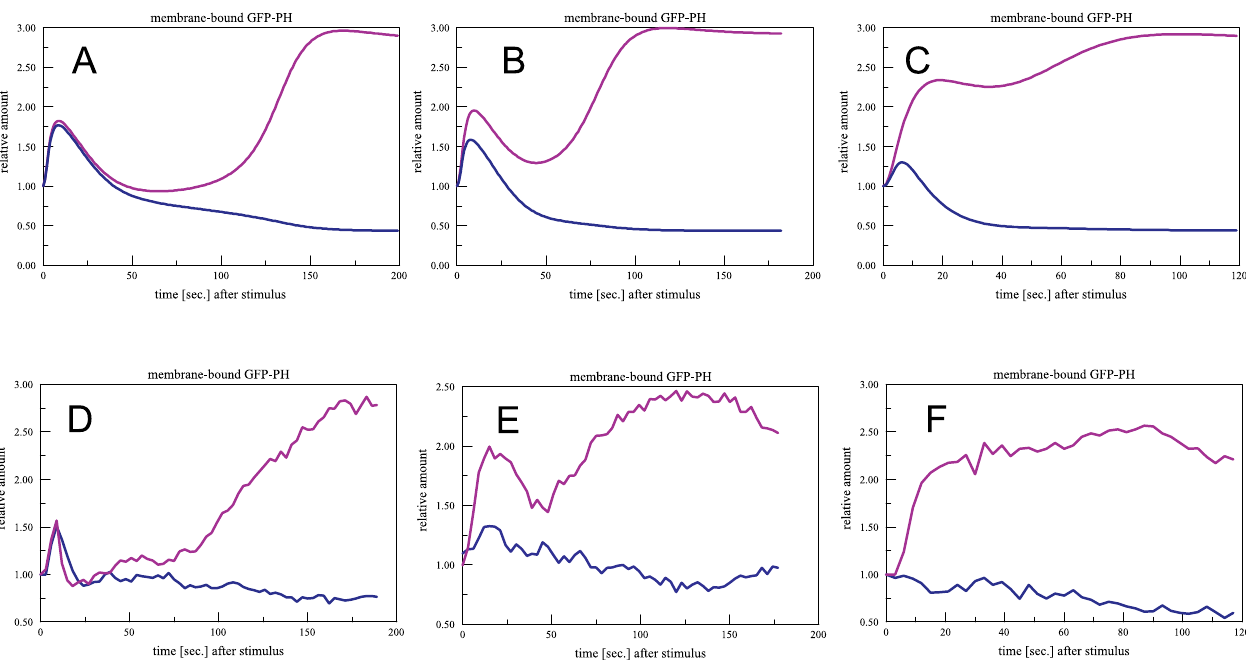
Figure 5. Correspondence in Time and Space between the Predicted and Measured Changes in PIP 3 at the Front and Back of Cells Exposed cAMP Gradients Experimental data from exposure of Dictyostelium to a 2:1 gradient with a mean cAMP concentration of 100 nmol were used to adjust model parameters. The other two responses are predictions of the model. (A), (B), and (C) are simulated responses. (D), (E), and (F) are experimental measurements, using PH-GFP to monitor PIP 3 levels in single cells exposed to gradients with a mean cAMP concentration of 1 l mol, 100 nmol, and 10 nmol. See Figure S6 for details on the full dataset of experimental replicates. DOI: